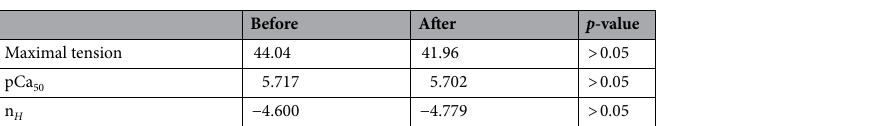
Before After p -value Maximal tension